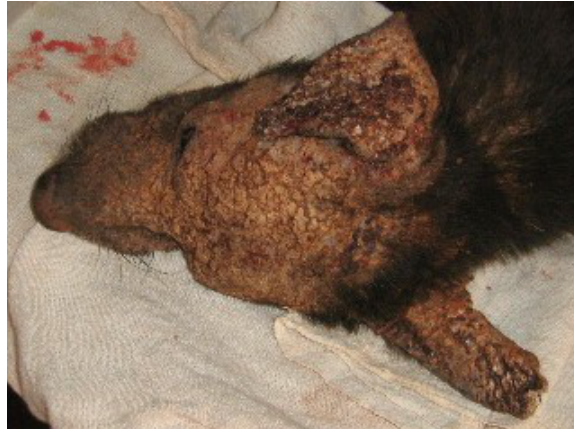
Figure 2 . Dog showing lymphadenopathy.